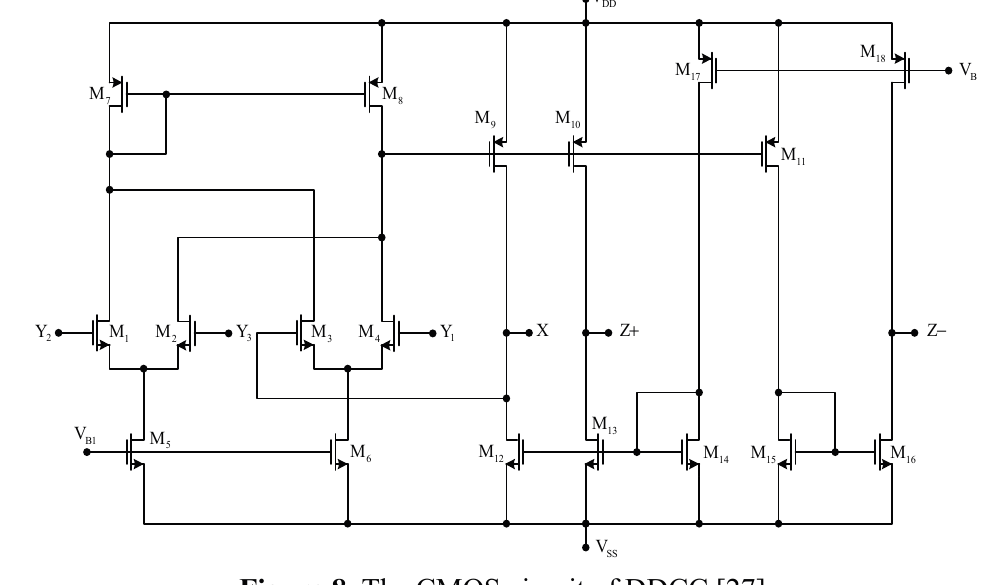
Figure 8. The CMOS circuit of DDCC